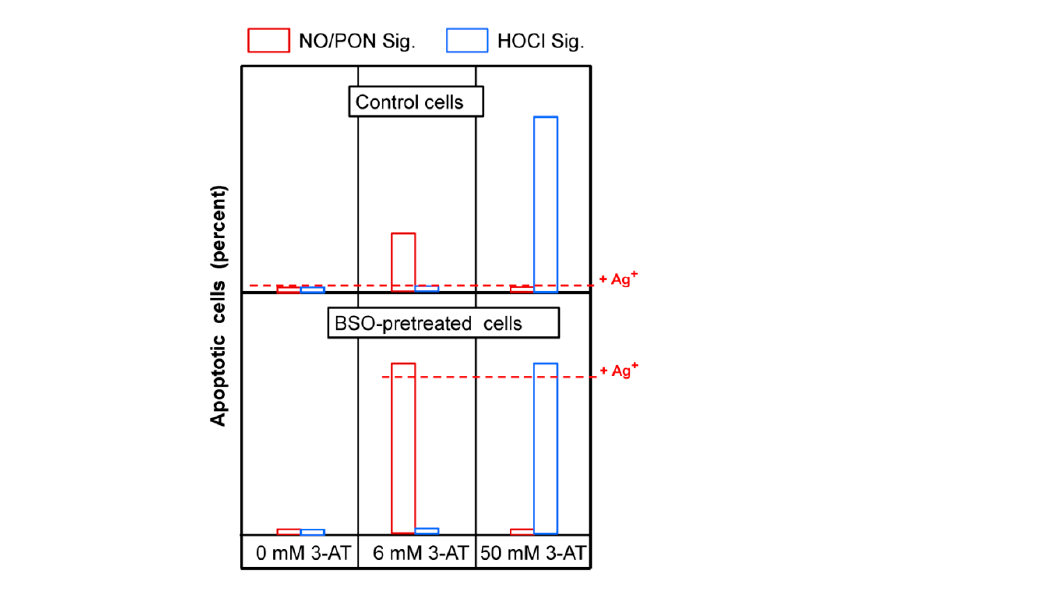
Figure 8. Apoptosis induction after glutathione depletion is dependent of catalase inhibition and intercellular ROS/RNS signaling, but independent on aquaporin action. MKN-45 cells were pretreated for 12 h at 37 ◦ C in the absence of BSO (“control”) or in the presence of 10 µ M or 50 µ M BSO. After preincubation, cells were washed and seeded in 96 well plates (12,500 cells/assay). Control cells ( A ), cells pretreated mit 10 µ M BSO ( B ), cells pretreated with 50 µ M BSO ( C ) and cells pretreated with 50 µ M BSO, plus addition of 5 µ M Ag + after pretreatment ( D ) remained without inhibitors or received either 20 µ M of the peroxynitrite decomposition catalyst FeTPPS or 50 mM of the HOCl scavenger taurine. 3-AT at the indicated concentrations was added to all assays and the percentages of apoptotic cells were determined after 4.5 h ( A ) or 3 h ( B – D ). The data show that 3-AT-dependent apoptosis induction in control cells and BSO-pretreated cells was due to initial NO/peroxynitrite signaling at lower concentrations of 3-AT, followed by HOCl signaling at higher concentrations. It is also seen that the enhanced apoptosis induction in BSO-pretreated cells at the left shoulder of the curve was essentially due to enhancement of NO/peroxynitrite signaling. Statistical analysis. Differential inhibition of NO/peroxynitrite and HOCl signaling by FeTPPS and taurine was highly significant ( p < 0.001). The scheme to Figure 8 illustrates that 6 mM 3-AT preferentially reactivates NO/PON signaling, whereas 50 mM 3-AT cause apoptosis induction through the HOCl signaling pathway. BSO pretreatment of the tumor cells does not allow for apoptosis induction in the absence of the catalase inhibitor but enhances NO/PON-mediated apoptosis induction and renders 3-AT-mediated apoptosis induction independent of aquaporin action.